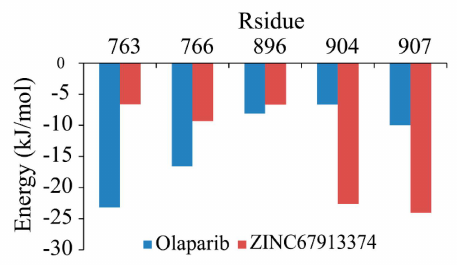
Figure 6. Binding free energy decomposition on a per-residue basis for olaparib- and ZINC67913374-PARP1